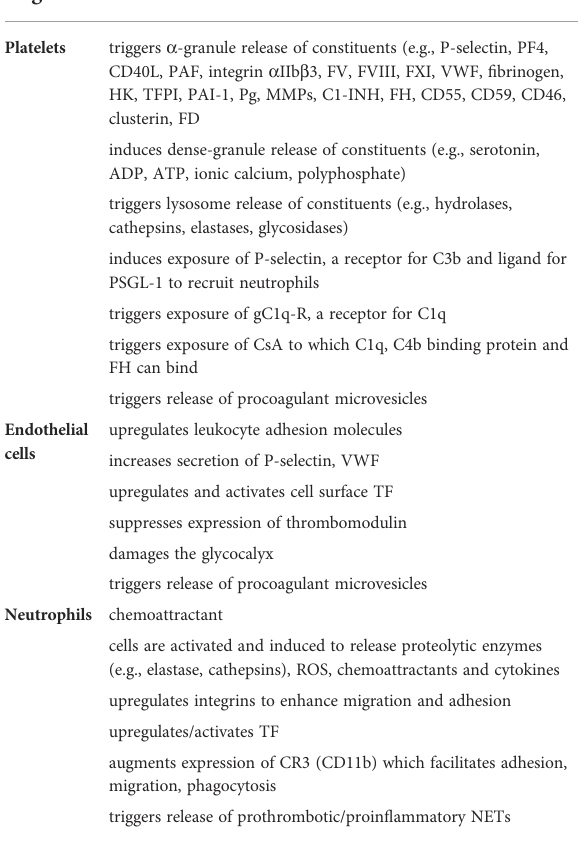
TABLE 2 Activities of complement factor C5a that modulate thromboin fl ammation. Cellular